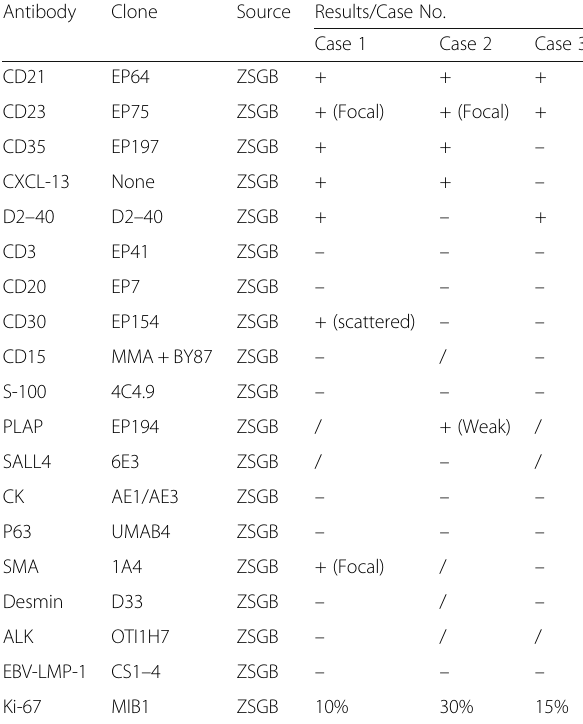
Table 1 Antibodies used for immunohistochemical staining and